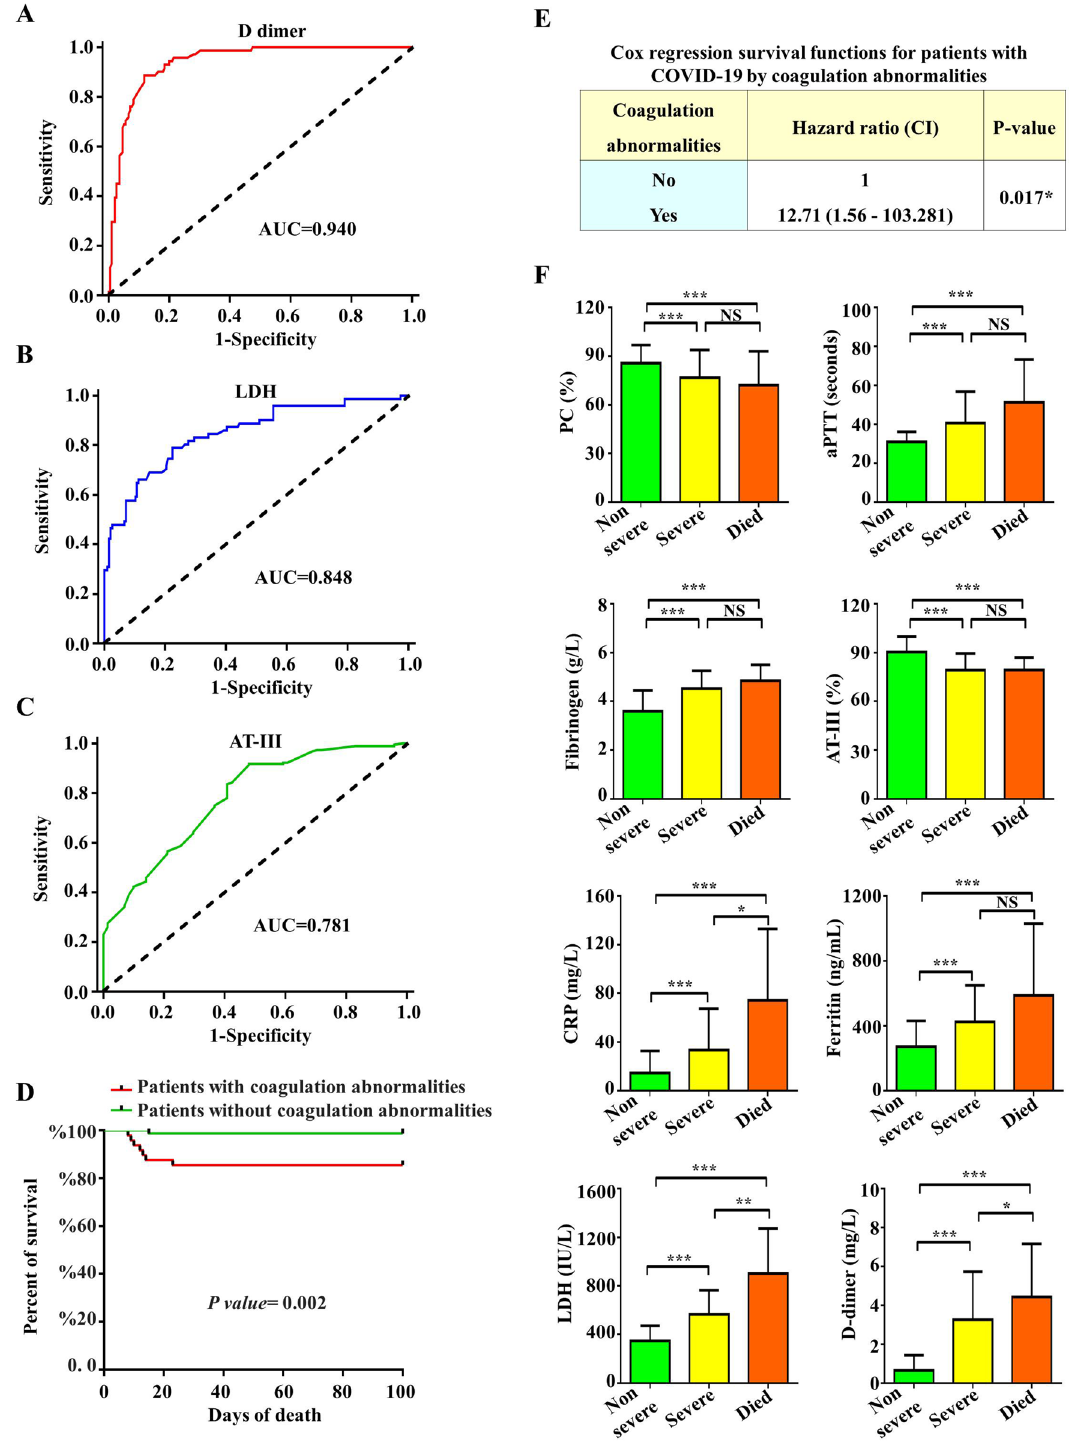
Figure 2. Receiver operator characteristic curves for D-dimer ( A ), LDH ( B ), and AT-III ( C ) levels of COVID- 19 patients in non-severe VS severe cases. ( D ) Kaplan–Meier estimator for comparison of survival functions for patients with COVID-19 by coagulation abnormalities. ( E ) Cox regression survival functions for patients with COVID-19 by coagulation abnormalities. ( F ) Characteristics of coagulation parameters and inflammatory biomarkers in death and survival group (non- severe and severe cases). Asterisks indicate significant P value. * indicated P value < 0.05, ** indicated P value < 0.01, *** indicated P value < 0.001. LDH lactate dehydrogenase, PC prothrombin concentration, aPTT activated partial thromboplastin, ATT-III antithrombin-III, CI confidence